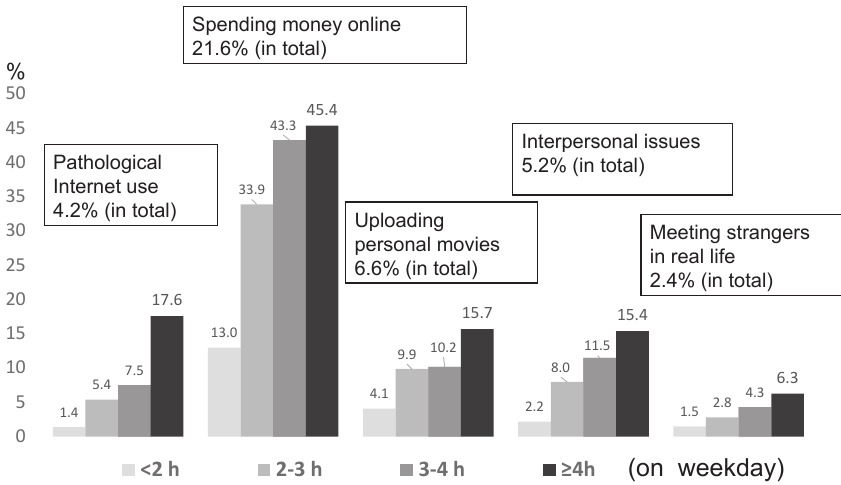
Figure 1. Prevalence of pathological Internet use (PIU) and risky behaviors by time. The associations between PIU, Internet- risky behaviors, and Internet time show a di ff erent trend. In the rate of PIU, there was a big di ff erence between Internet time 3 to < 4 hours (7.5%) and ; 4 hours (17.6%), while big di ff erences existed between < 2 hours and ; 2 hours in the rates of spending money online (13.0% vs 33.9%), uploading personal movies (4.1% vs 9.9%), and interpersonal issues (2.2% vs 8.0%).